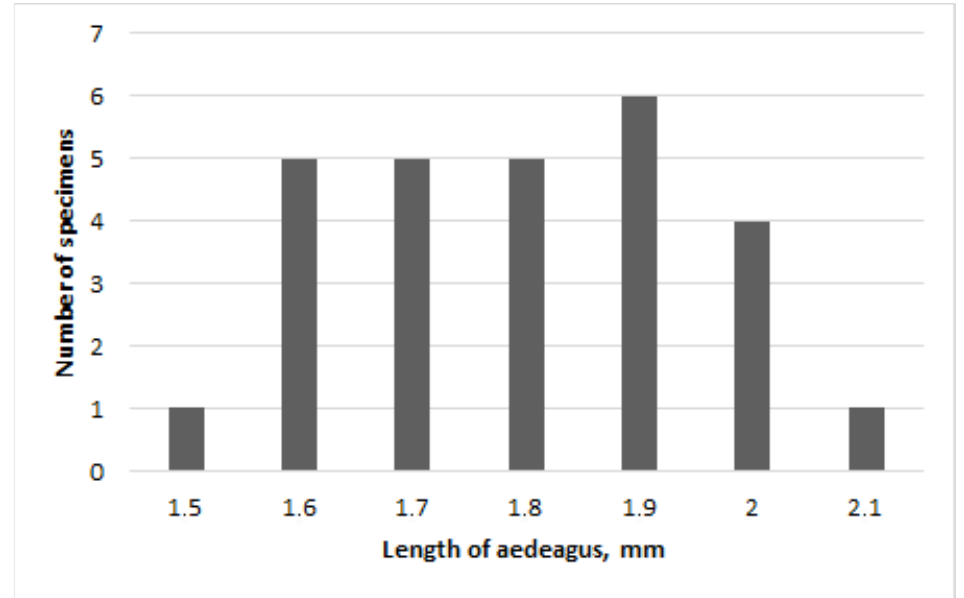
Figure 4. Chrysolina fascinatrix , length of male aedeagus.